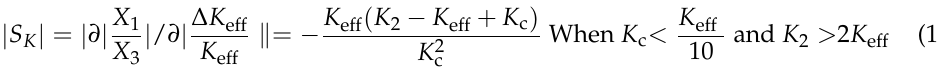
Figure 4. The mass-stiffness-damper model of three coupled resonators.